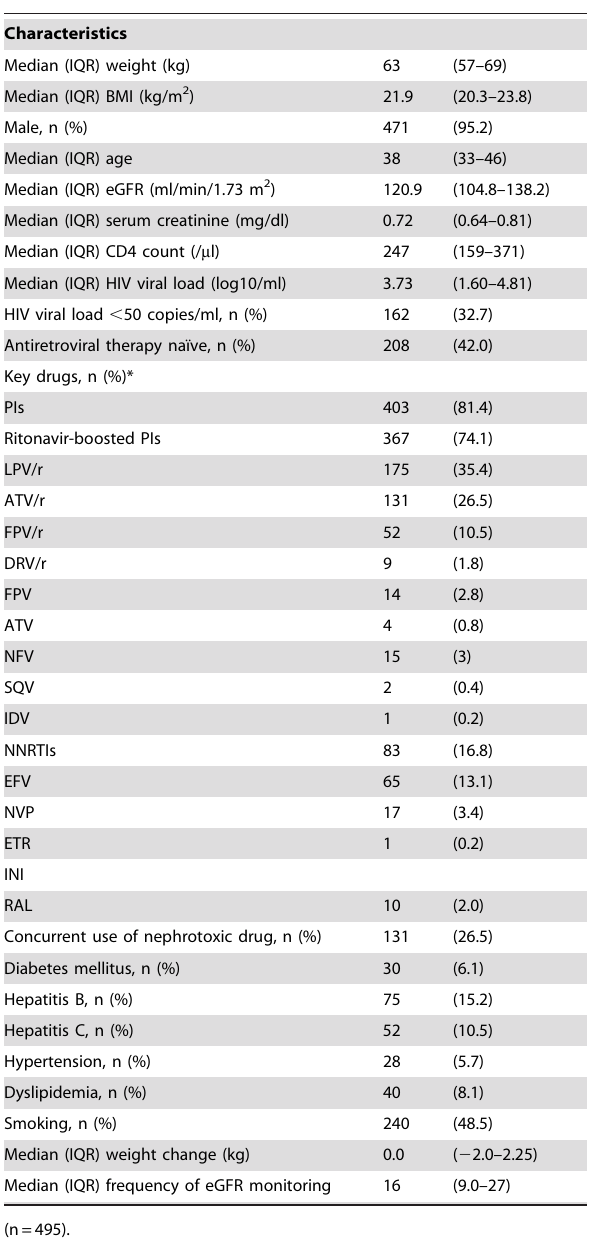
Table 1. Baseline demographics and laboratory data.